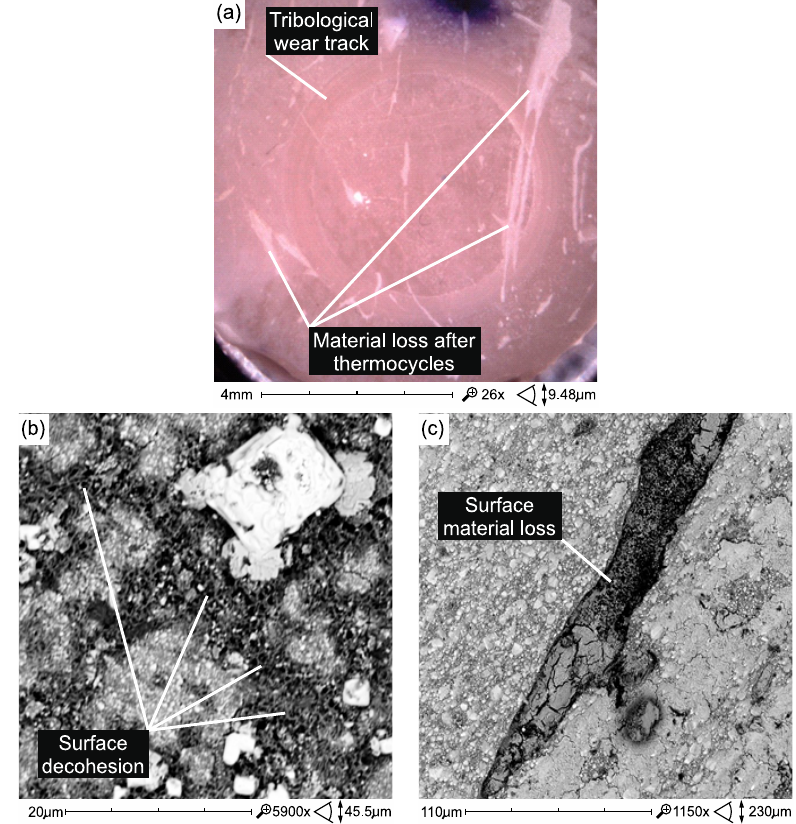
Figure 11. Non-tribological damages accompanying tribological wear caused on the surface of Z550 material samples as a result of thermocycling: ( a ) surface losses of the material and surface roughness increase (Z550); ( b ) surface decohesion (Z550); ( c ) material loss (Z550).